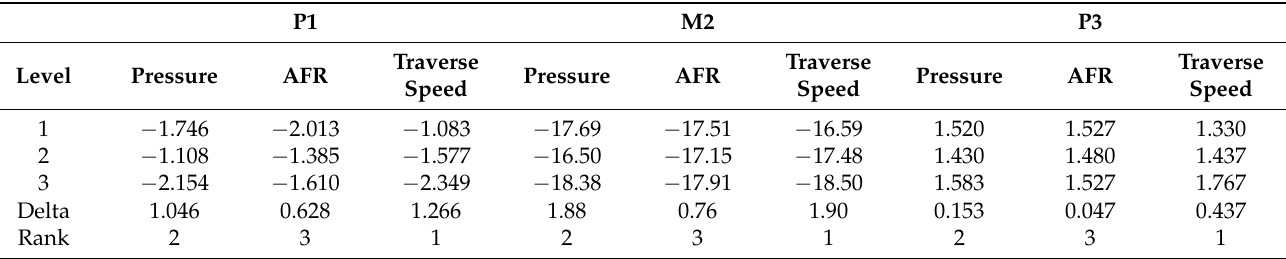
Table 3. Response Table for Signal to Noise (S/N)